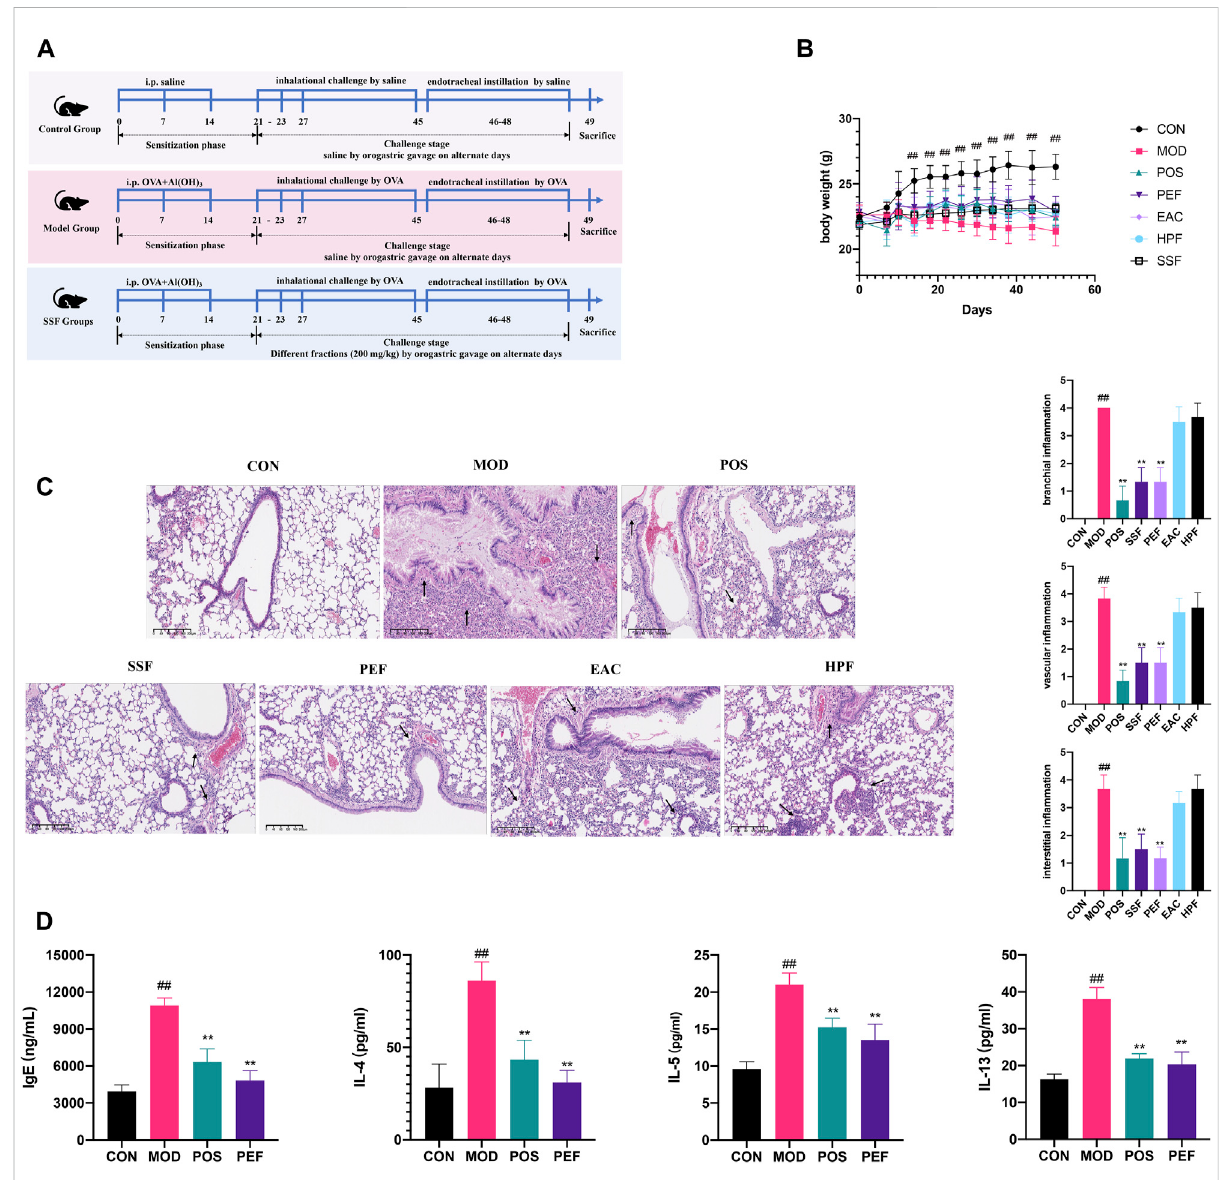
FIGURE 2 Active fraction screening of SSF. (A) Timeline of the animal experimental protocol. (B) Bodyweight records of the mice during the experiment ( n = 6). (C) Pulmonary HE staining (× 10) and in fl ammation scores. (D) Expressions of in fl ammatory cytokines in serum. (## p < 0.01 v. s. CON group. ** p < 0.01 v. s. MOD group. * p < 0.05 v. s. MOD